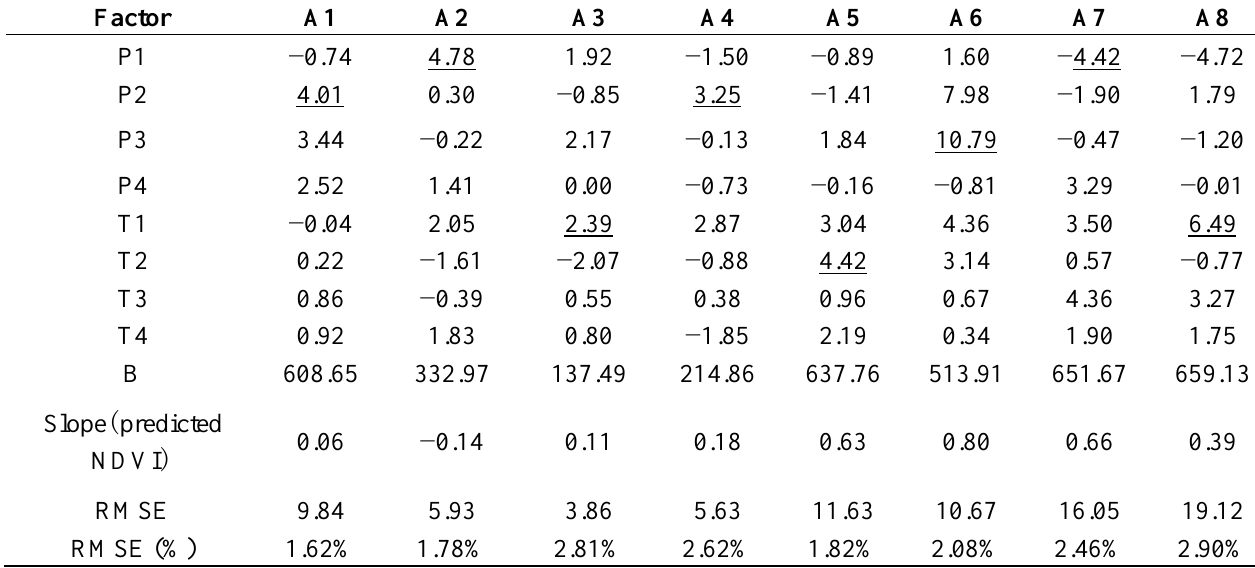
Table 3. Coefficients (CES) of multiple regression models in each sub-region (10 −3